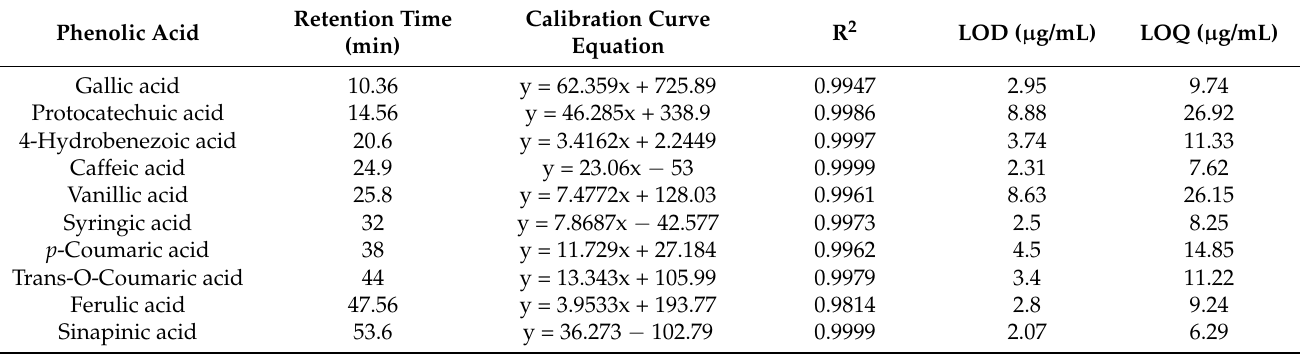
Table 2. Detection and quantification data of external